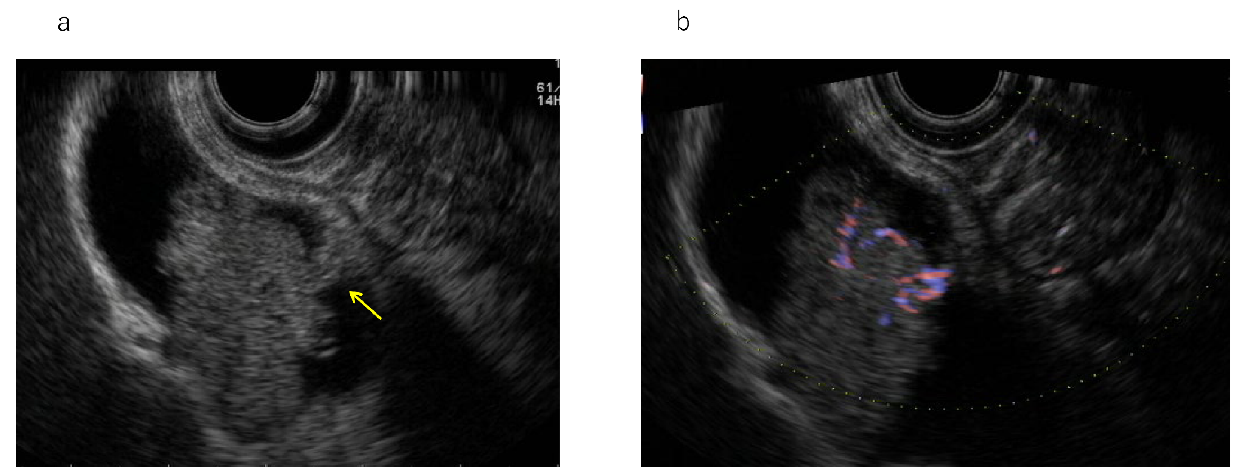
Figure 2. Gallbladder adenoma. ( a ) Endoscopic ultrasonography (EUS): Pedunculated elevated lesion (arrow). ( b ) EUS (Doppler mode): Linear blood flow in the peduncle.